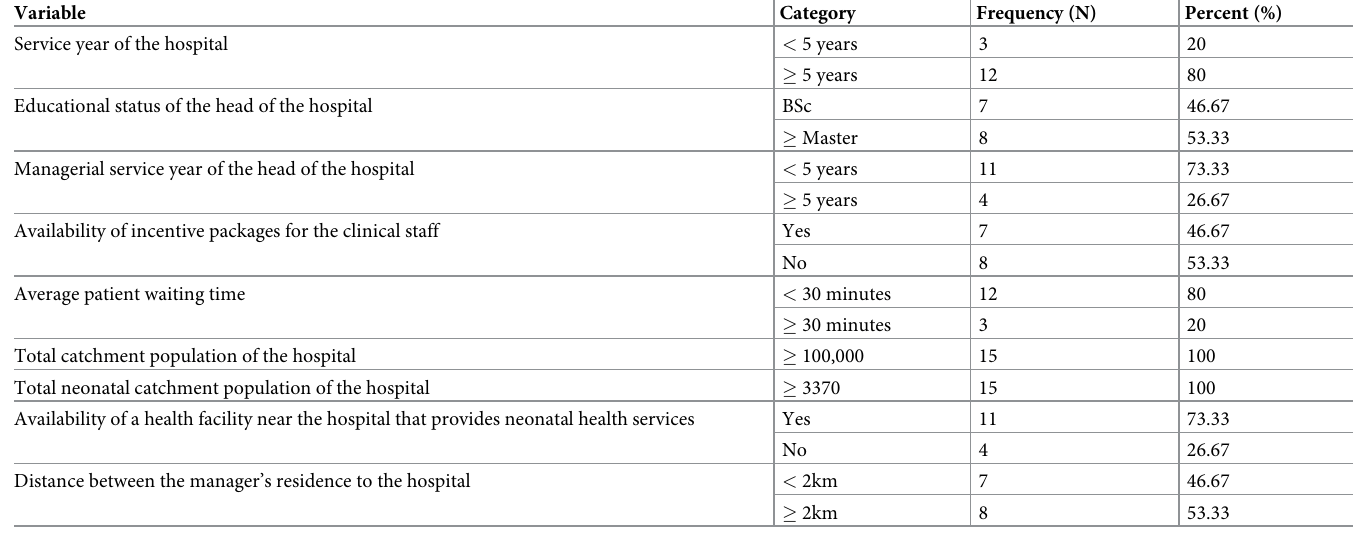
Table 1. Organizational and environmental characteristics of primary hospitals towards neonatal health services provision in three zones of Northwest Ethiopia, 2021 (N = 15 DMUs).